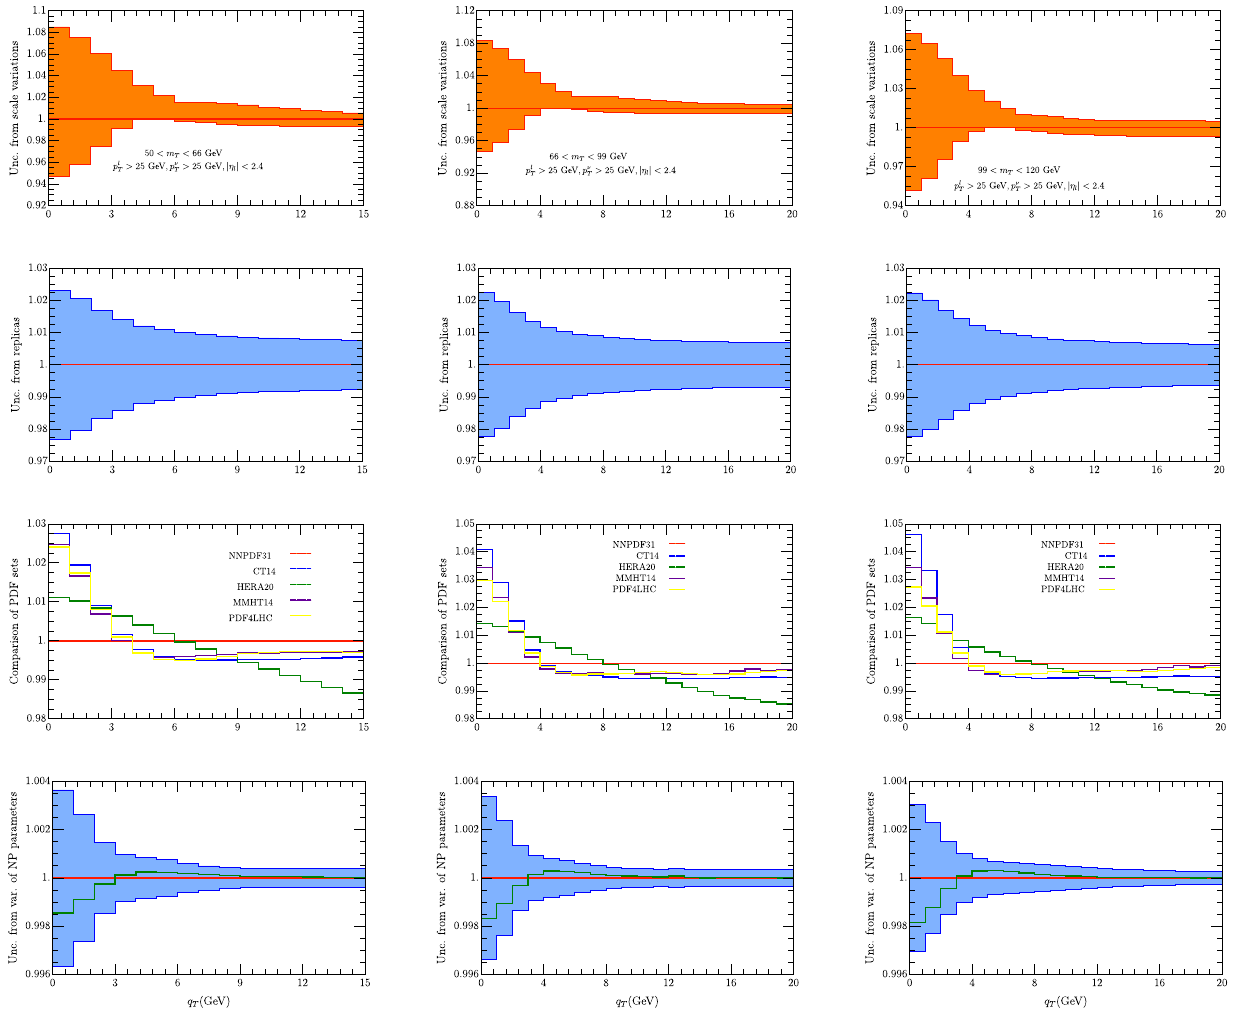
> 25 GeV, | η | < 2 . 4 Fig. 2 Error for W − cross section for p l ,ν is referred to the average value of each bin (red line). The value of the l T cross section given by the central replica is represented by the green and the m T intervals [ 50 , 66 ] GeV (left column), [ 66 , 99 ] GeV (middle line. On the third line we represent the value of each been with different column), [ 99 , 120 ] GeV (right column). In the first line we report the sets of PDF. On the fourth row we have the uncertainty due to non- theoretical error from scale uncertainties as explained in the text. In the perturbative parameters. The central value is given by the the central second line we have the error calculated as a variance in each bin of replica of NNPDF31_nnlo_as_0118 100 replicas of the set NNPDF31_nnlo_as_0118 [28]. The uncertainty